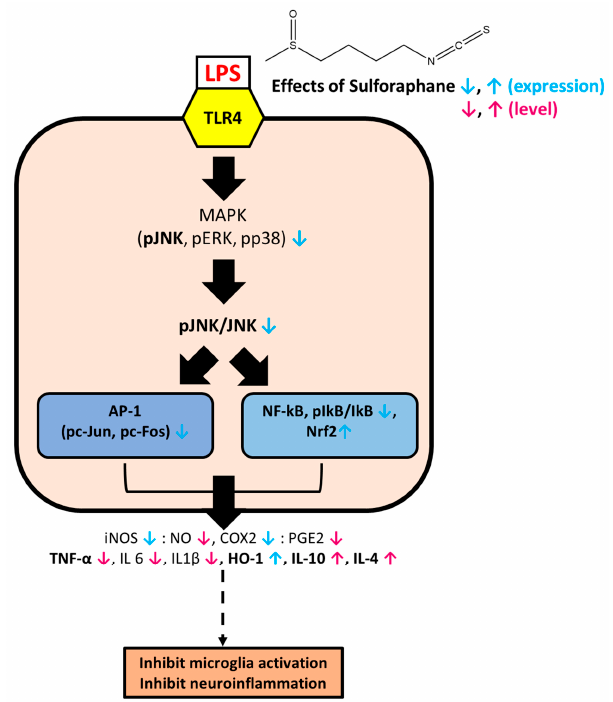
Figure 9. Hypothetical model of the SFN-mediated anti-inflammatory effect via JNK/AP-1/NF- κ B pathway inhibition and Nrf2/HO-1 pathway activation, with subsequent upregulation of IL-10 and IL-4. Supplementary Materials: Supplementary materials are available online at http://www.mdpi.com/2073-4409/